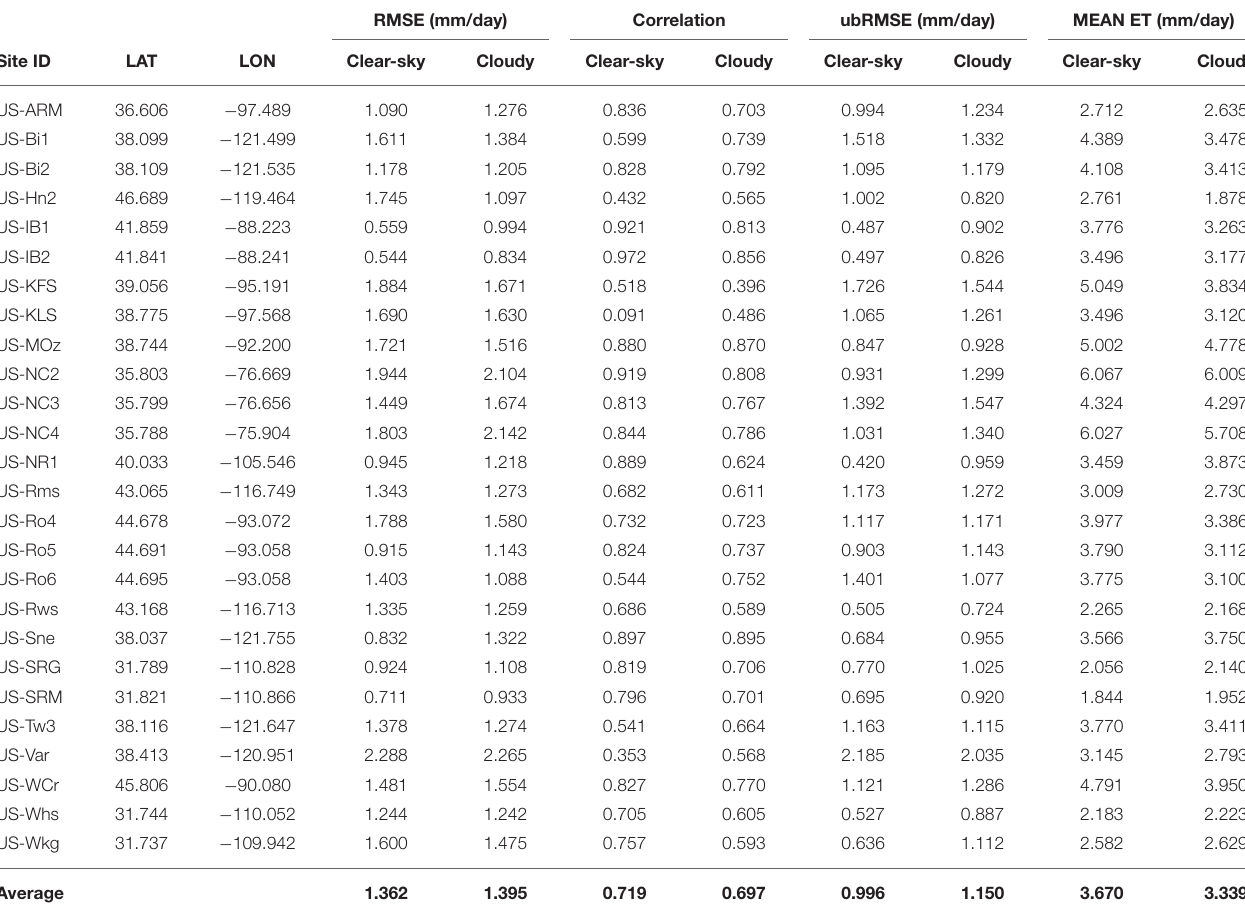
TABLE 4 | Statistical comparison of GET-D ET estimates with in-situ measurements over a period from July 2017 to July